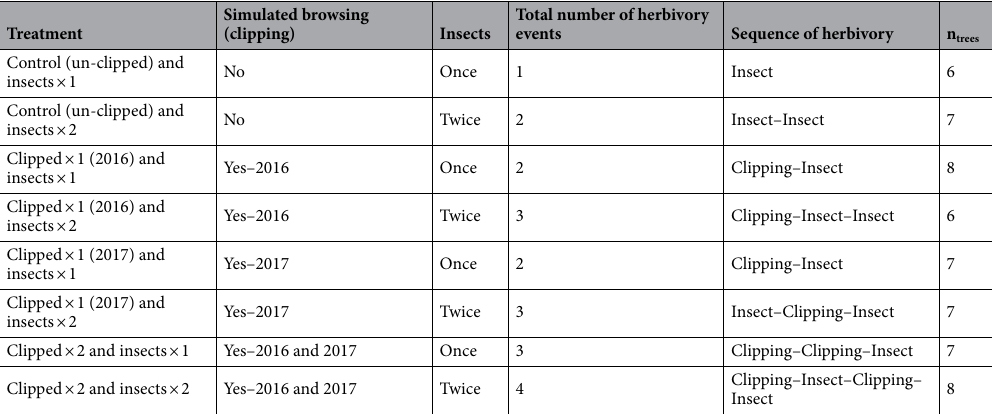
Table 3. Herbivory treatments in 2017. The first column explains the full treatment, the second which browsing treatment and the third which insect treatment the trees were exposed to. The fourth column contains the number of herbivory events per treatments and the fifth the sequence of herbivory. The sixth column contains the number of trees per treatment (sample